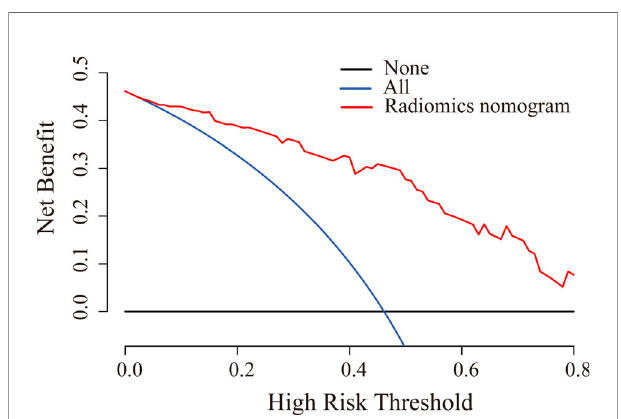
FIGURE 7 | DCA for radiomics nomogram in the validation cohort. The y-axis indicated the net bene fi t. The red line, blue line, and horizontal black line represented the net bene fi t of the radiomics nomogram, treat-all strategy, and treat-none strategy,